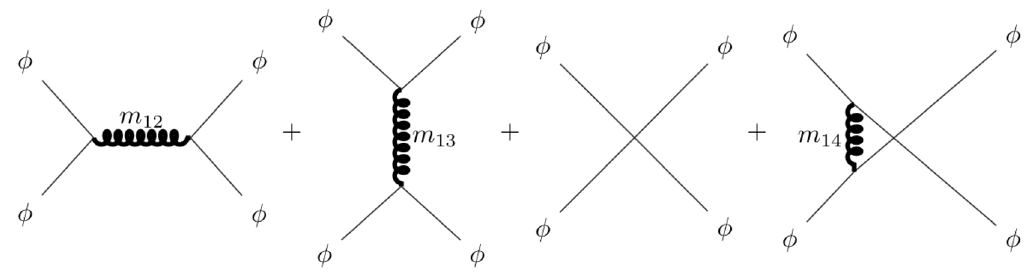
Figure 1 . Feynman diagrams showing the φφ → φφ process. Note that the bold curly line represents a gluon and m ij = 0 .